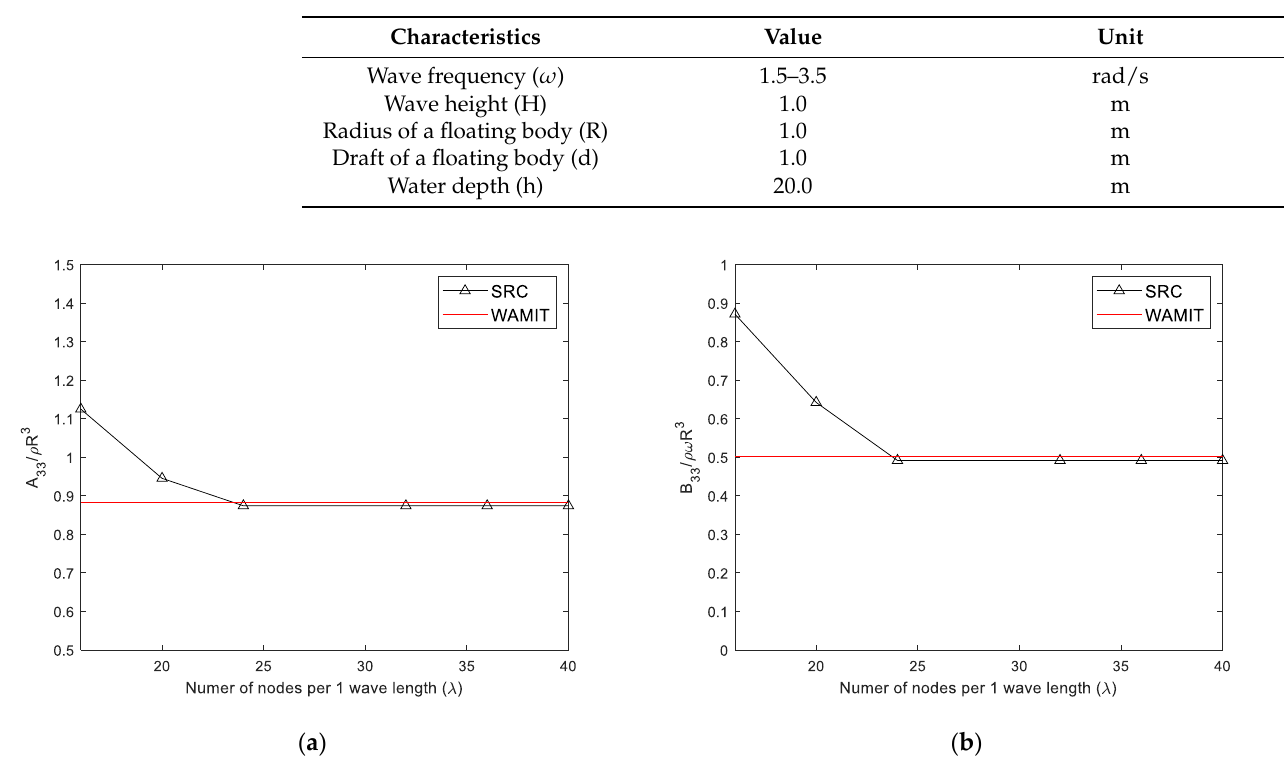
Figure 3. Convergence test for the number of nodes per wavelength with Sommerfeld radiation condition ( 𝜔 = 3.2 rad/s): ( a ) heave added mass; ( b ) heave radiation damping